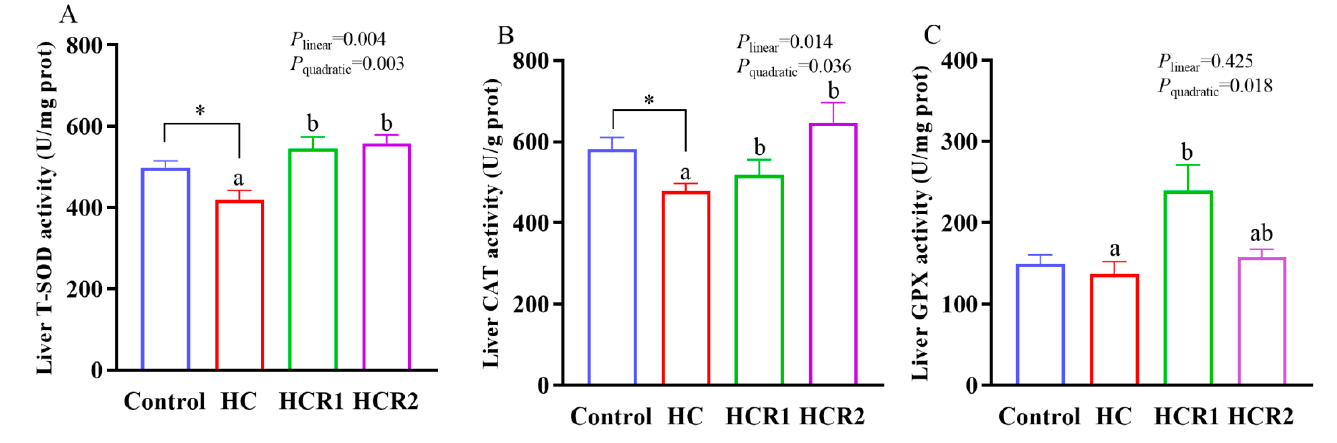
Figure 1. Liver T-SOD ( A ), CAT ( B ), and GPX ( C ) activities as well as GSH ( D ) and MDA ( E ) con- tents. Each data point represents the mean of four replicates (4 individuals per replicate). * Means p < 0.05, compared between the control and the HC group. ab Compared among the HC, HCR1, and HCR2 group. Bars assigned with different superscripts are significantly different ( p < 0.05). Control, diet with 32% nitrogen-free extract; HC, diet with 45% nitrogen-free extract; HCR1, diet with 45% nitrogen-free extract and 0.04% resveratrol; HCR2, diet with 45% nitrogen-free extract and 0.08% resveratrol. MDA, malondialdehyde; CAT, catalase; GSH, L-glutathione reduced; GPX, glutathione peroxidase; T-SOD, total superoxide dismutase. 3.3. Tissue and Plasma Metabolites Concentrations As presented in both Figures 2 and 3, dietary treatments had no significant effect ( p > 0.05) on the concentrations of TG and HDL-C in the plasma. However, the concentra- tion of TG in the HC group was remarkably higher ( p < 0.05) than that of the control group in the liver. A similar result was also found in the concentration of TC in the plasma, liver, and hindgut. In addition, tissue TC content and liver TG content de- creased both linearly and quadratically ( p < 0.05) with increasing dietary resveratrol lev-